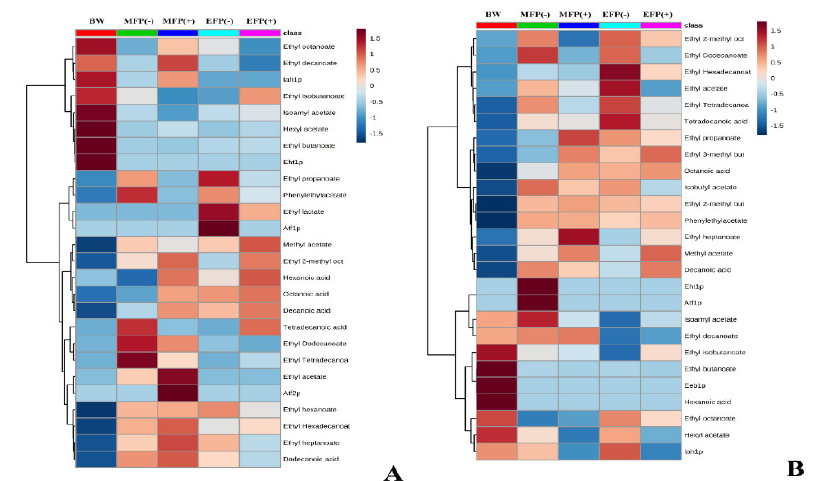
Figure 1. Heat map of the group of metabolites and proteins for flor yeast ( A ) and the P29 strain ( B ). *The dendrograms that indicate the grouping of variables and can be visualized in the left of the diagram. The key shown indicates the tones associated with values in the cells. In order to make full use of the shadow information, the data are normalized. The average of each condition is represented in the first top row: base wine, BW; middle of the fermentation without CO 2 overpressure, MFP (-), middle of the fermentation with CO 2 overpressure, MFP (+); final fermentation without CO 2 overpressure, EFP (-); final fermentation with CO 2 overpressure, EFP (+).